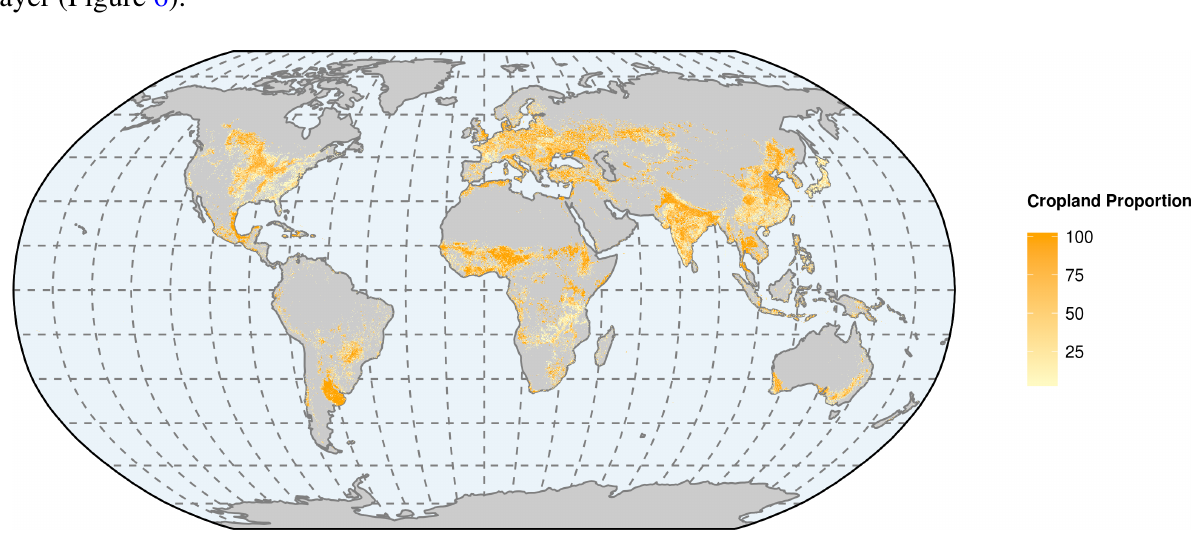
Figure 6. Cropland proportion from the Unified Cropland Layer at 250-m for the year 2014. The Unified Cropland Layer combines the best performing products with regards to the multi-criteria analysis. It should be noted that cropland proportions are likely to be overestimated in areas where the spatial resolution of the original product is not higher than